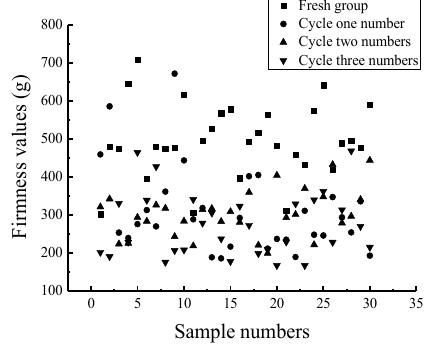
Figure 6. Scatter plot of the distribution of the firmness values of the Nanguo pears.